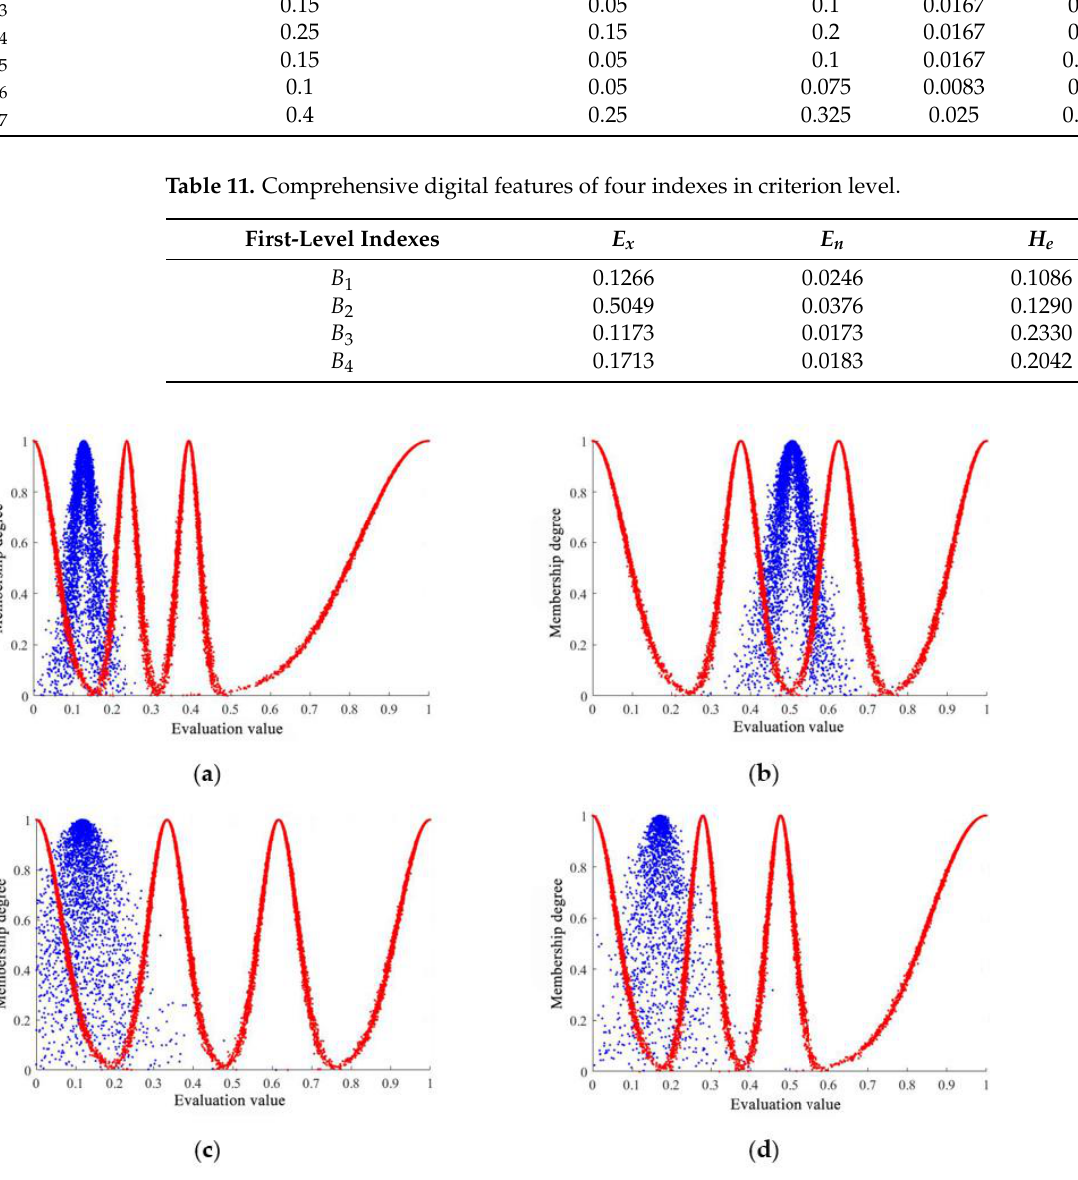
Figure 7. Cloud picture of comprehensive risk evaluation of all indexes. Table 12. The similarity between the roof risk assessment cloud pictures and the standard cloud pictures. Comprehensive Evaluation Indexes